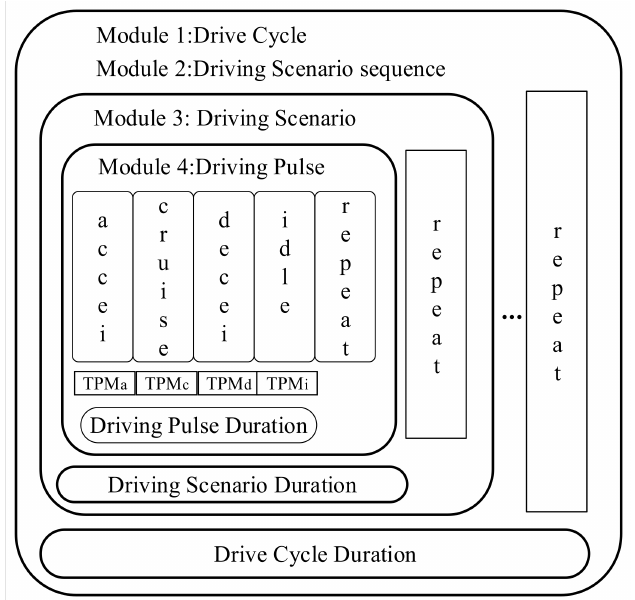
Figure 9. Graphical illustration of the DC production